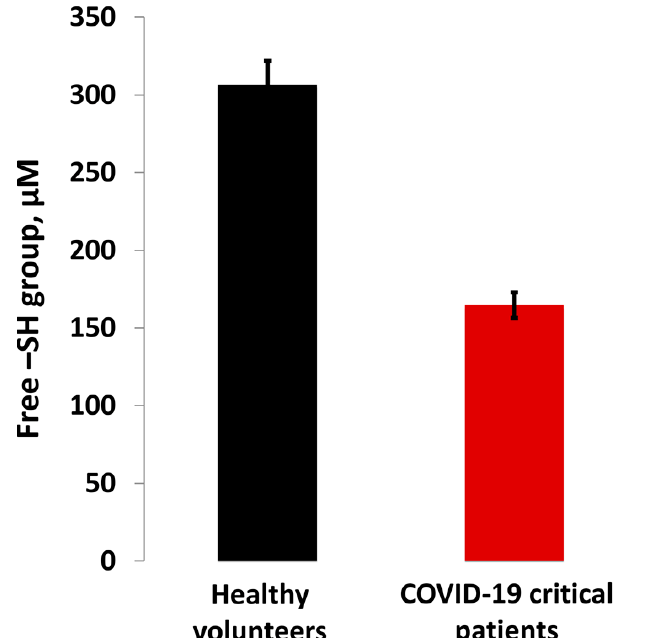
Figure 7. The level of oxidized HSA in the serum samples of COVID-19 patients and healthy vol- unteers. Double-integrated EPR spectra of the 3-Maleimido-PROXYL radical (200 µM) after incu- bation for 120 min. Control of 3-Maleimido-PROXYL/DMSO without serum (in black), spectra of 3-Maleimido-PROXYL in serum samples from patients with COVID-19 (from red to yellow), and 3-Maleimido-PROXYL in serum samples from healthy patients (in blue). Results are presented as the percent value of control, 3-Maleimido-PROXYL/DMSO.